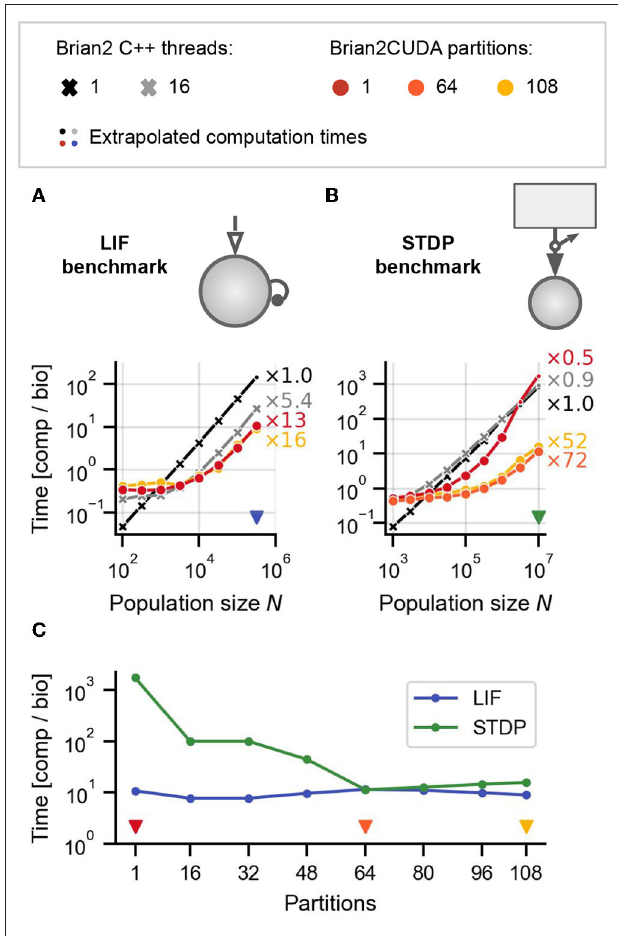
FIGURE 6 | Benchmark results for networks with heterogeneous delays. (A) LIF benchmark model from Figure 5C but with heterogeneous delays. (B) STDP benchmark from Figure 5D but with heterogeneous delays. Delays for all synapses in both models (A,B) were uniformly sampled d ij ∼ U (0,4) ms . The external drive for the LIF benchmark was additionally modified to maintain the same regime of network activity as in the case of homogeneous delays (see Section 2.5.1.2). (C) Computation times for LIF (blue line) and STDP (green line) benchmarks for different numbers of connectivity matrix partitions in Brian2CUDA, for the maximal network sizes from (A,B) [indicated with blue and red triangular markers in (A,B) ]. Triangular markers in (C) indicate the number of partitions plotted in (A,B) in the corresponding colors. All simulations were performed as described in Figure 5